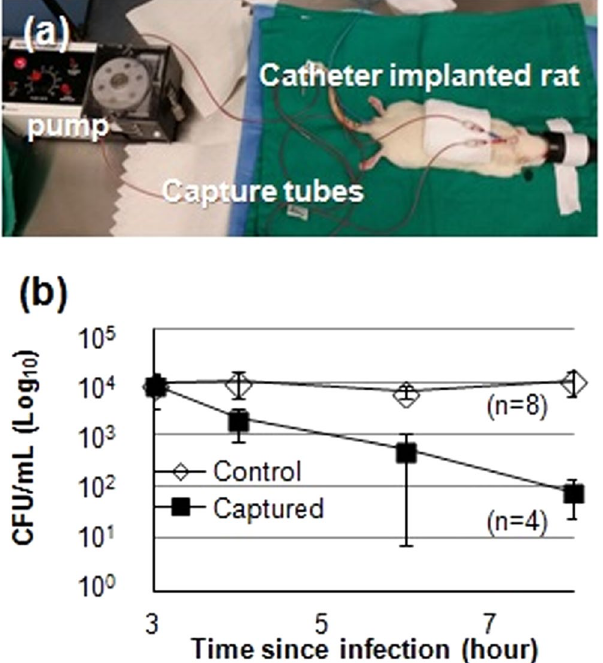
Figure 3. In vivo tube capturing results. ( a ) Experimental set-up. ( b ) Average bacterial density in collected blood from rats over time (y axis in logarithmic